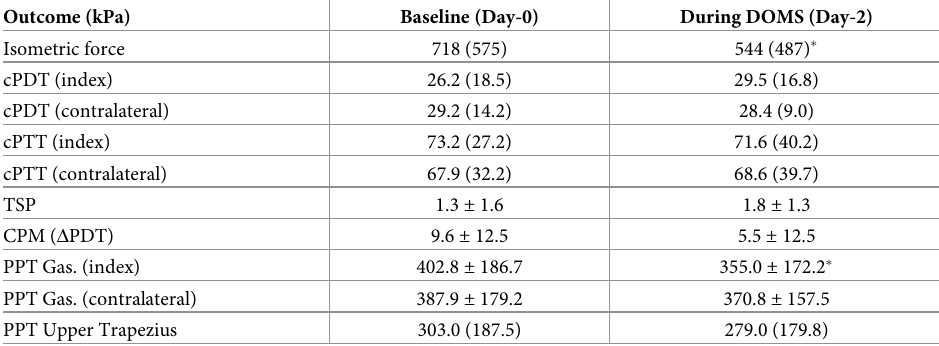
Table 2. Isometric force production and pain sensitivity data at Day-0 and Day-2.